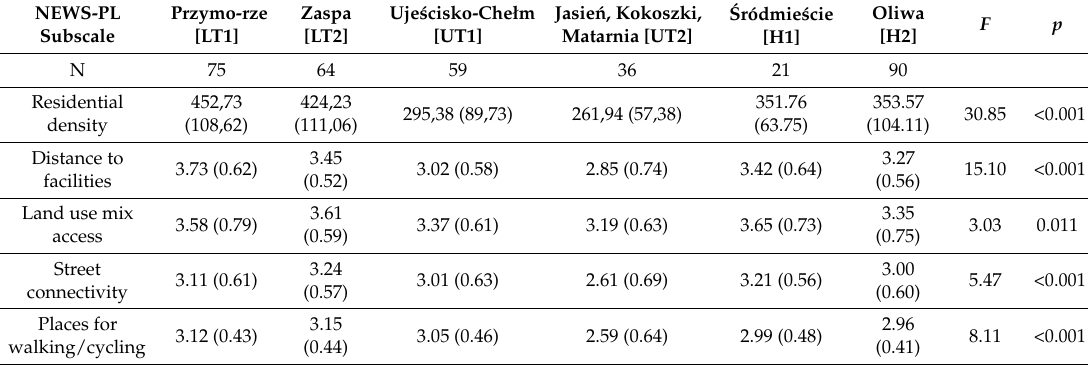
Table 4. NEWS-PL subscale scores among various type of neighbourhood in